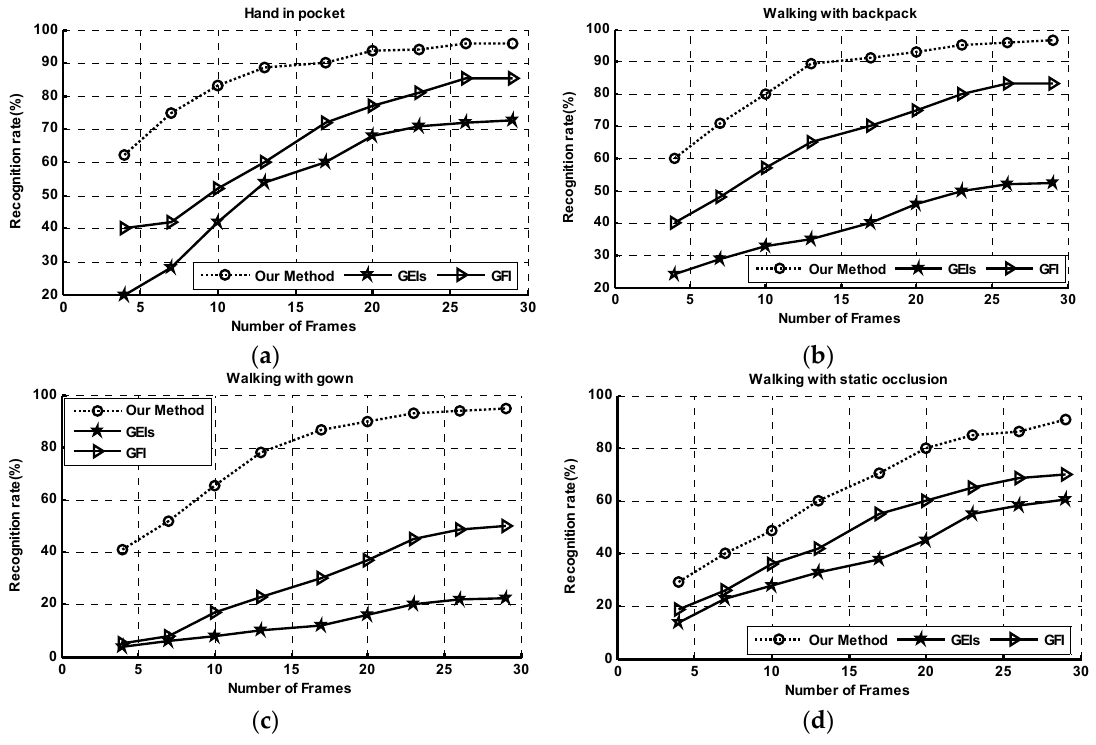
Figure 13. Recognition rates compared with flexible probe frames.